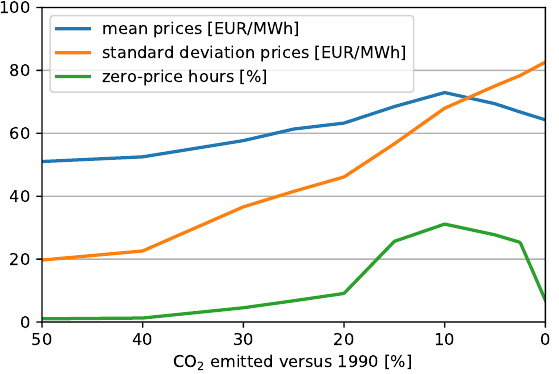
Figure 9. Load-weighted statistics of electricity prices.